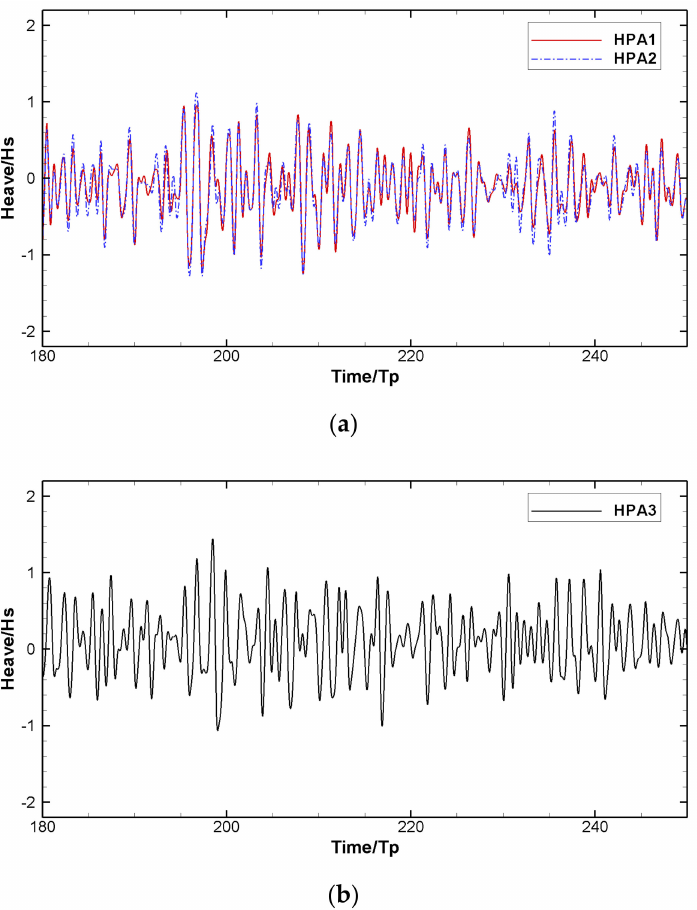
Figure 19. Heave motion of multiple HPAs connected to the large semi-submersible (Hs = 3.0 m, Tp = 6.67 s, Vc = 0.14 m/s); ( a ) HPA1 and HPA2 (at the weather side); ( b ) HPA3 (at the lee